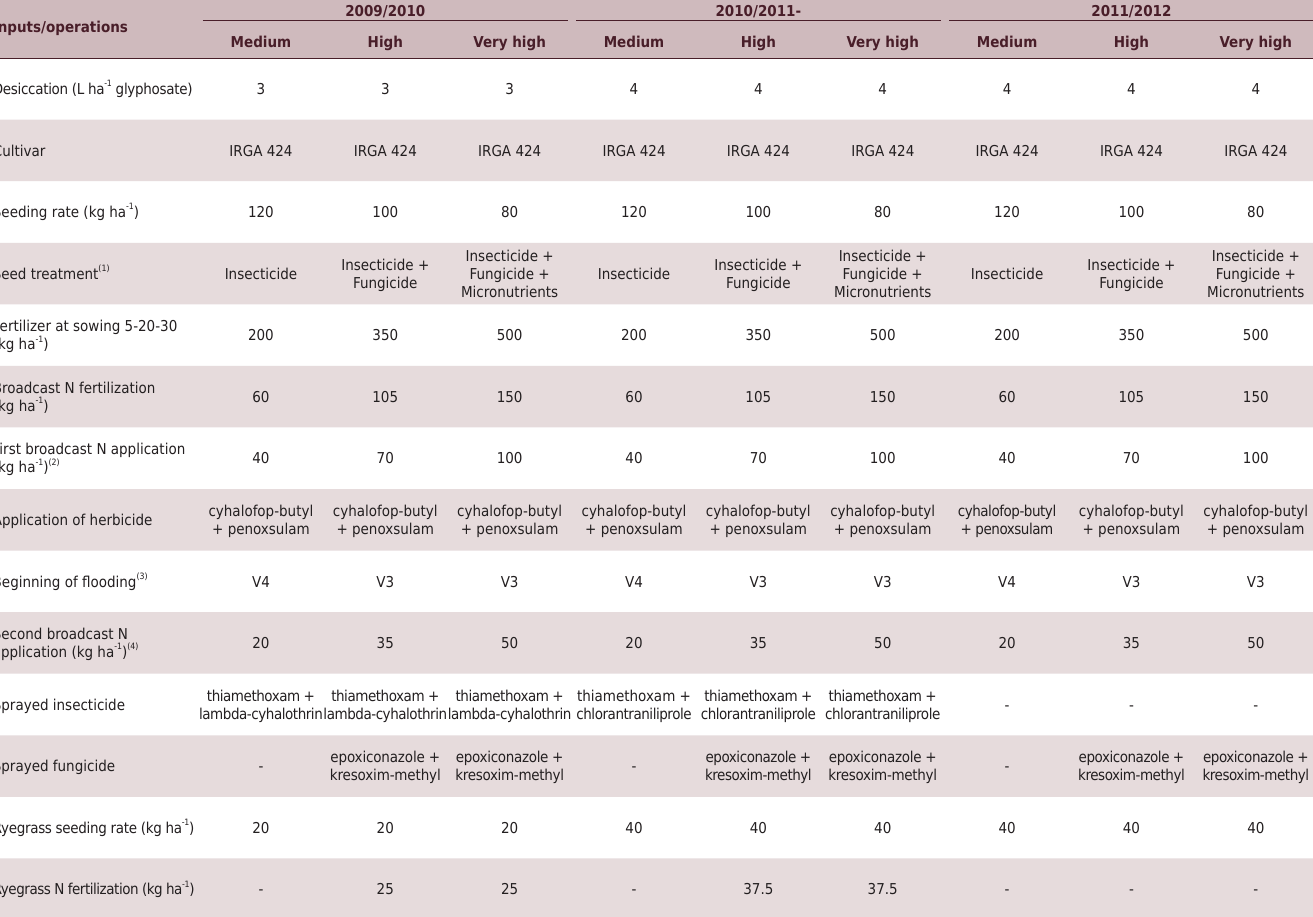
(1) Insecticide: fipronil; fungicide: carboxin + thiram. (2) Performed at stages V 4 , V 3 , and V 3 according to the scale of Counce et al. (2000) at the medium, high, and very high level, respectively. (3) According to the scale of Counce et al. (2000). (4) Performed at stages V 7 -V 8 according to the scale of Counce et al. (2000) at all levels. - : not